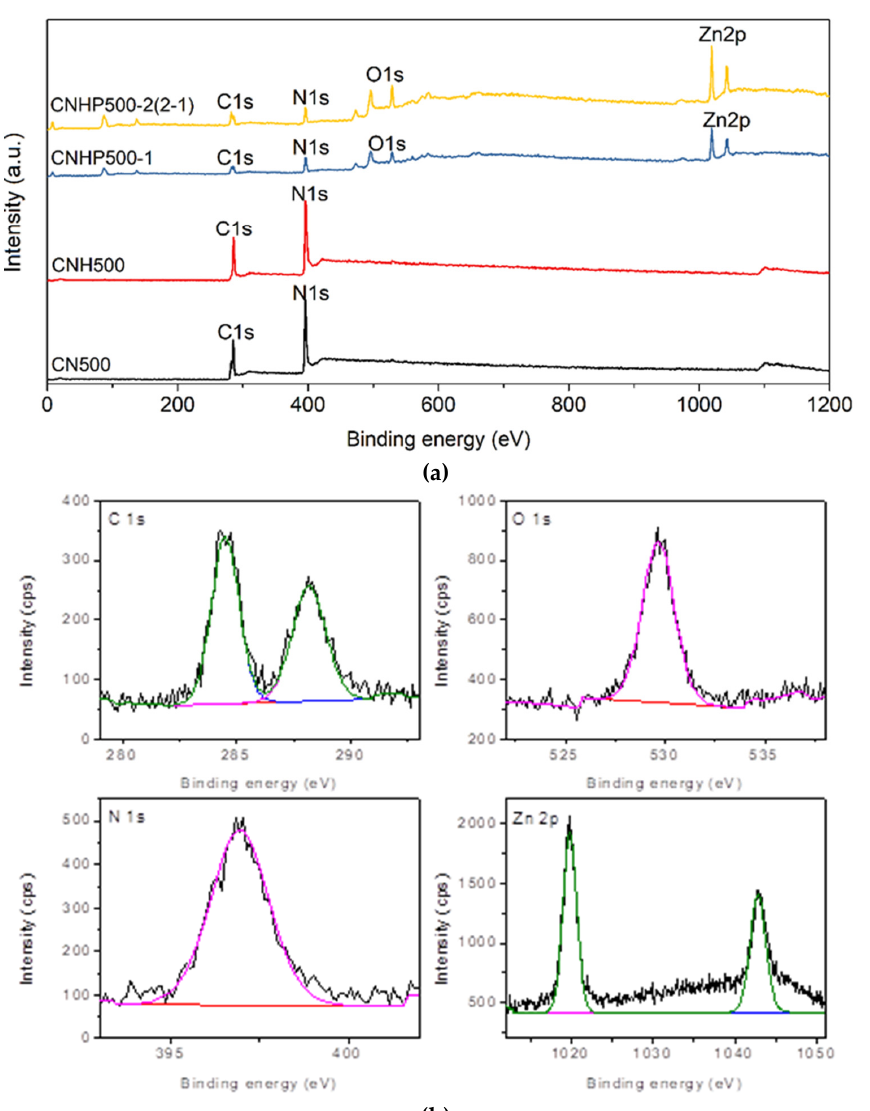
Figure 5. ( a ) Wide x-ray photoelectron spectroscopy (XPS) spectra for sample CN500, CNH500, CNHP500-1, and CNHP500-2(2-1) and ( b ) the corresponding Gaussian–Lorenzian deconvolution shapes for C1s, O1s, N1s, and Zn 2p of sample CNHP500-2(2-1). For the final analysis, the adsorbent samples were further tested for CO 2 adsorption- desorption activity at low temperature and pressure. Figure 6 represents the adsorption curves (a), desorption curves (b), and CO 2 capture capacity (c) for all samples. In the mean- time, Figure 6(d) represents the adsorption capacity of sample CNHP500-2(4-1), CNHP500-2(3-1), and CNHP500-2(2-1) for three consecutive cycles. Based on adsorption and desorption curves, the samples CNHP500-2(3-1) and CNHP500-2(4-1) exhibited a longer time for CO 2 adsorption compared to other samples, but steeper curves of desorp- tion were shown, suggesting a more complex and time-consuming desorption process. On the other hand, CNHP500-2(2-1) and CNHP500-1 samples demonstrated a rapid and easy desorption of CO 2 , which is beneficial for efficient adsorption cycle.